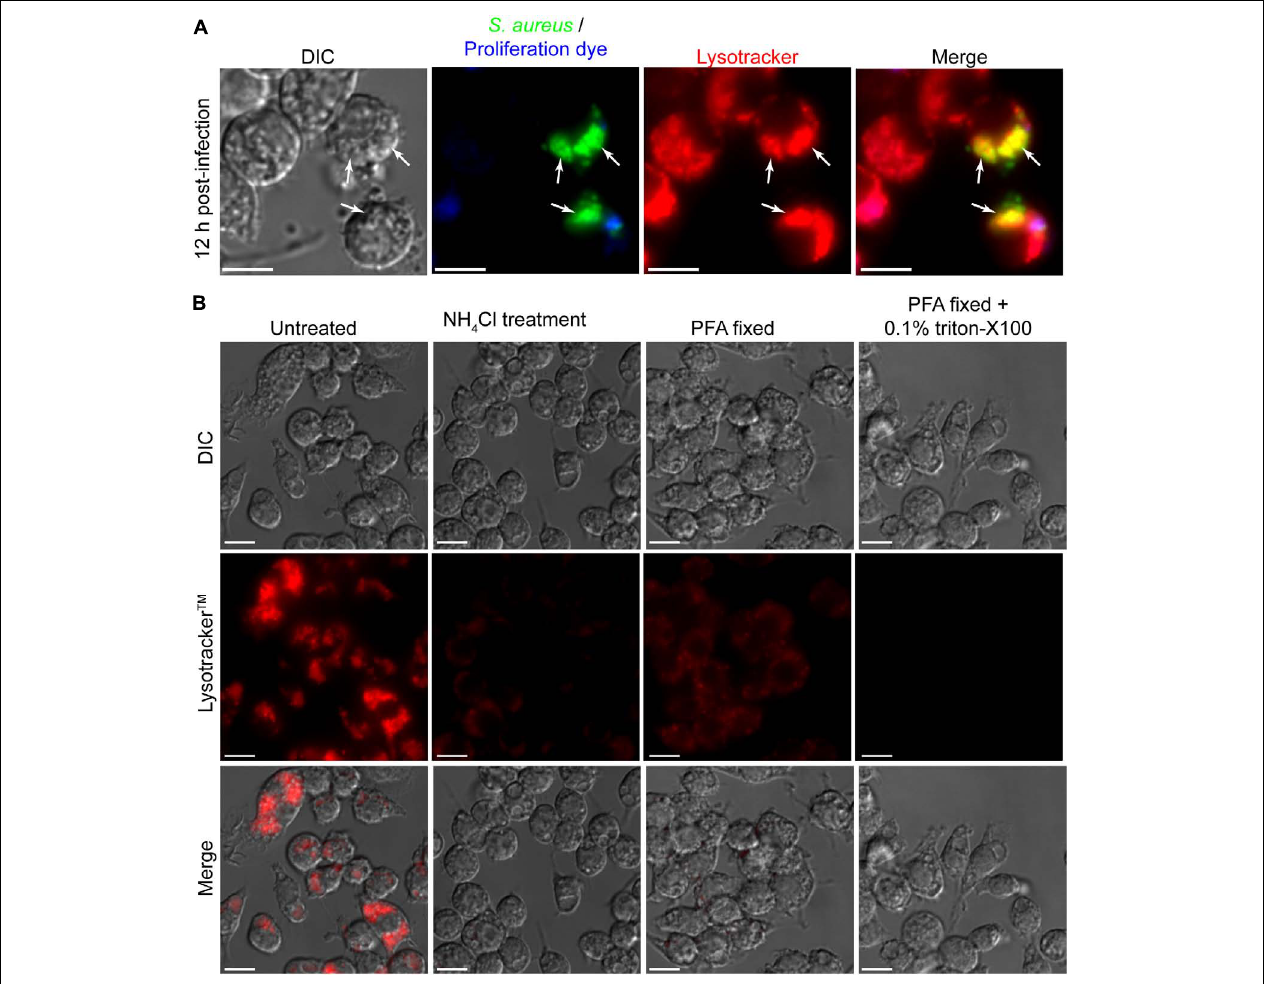
FIGURE 6 | Cellular probes such as Lysotracker TM Red DND-99 are compatible with the fluorescent reporter of proliferation dye. In (A) RAW 264.7 macrophages containing live S. aureus were stained with Lysotracker TM and imaged by live cell fluorescence microscopy. At the outset of infection GFP-expressing bacteria were labeled with eFluor TM -670 and here at 12 h post-infection GFP-positive yet eFluor TM -670 negative bacteria can be detected (white arrows). These bacteria also co-localize with Lysotracker TM . Scale bar is ∼ 10 µ m. In (B) RAW macrophages that were uninfected were stained with Lysotracker TM and imaged either live, after fixation, or after fixation and permeabilization. These representative images were acquired under the same acquisition parameters to allow for direct comparison of fluorescence intensities and represent observations made from more than six independent experiments. In one instance, live RAW cells were first treated with 40 mM of the weak base NH 4 Cl prior to lysotracker staining. Scale bars equal ∼ 10 µ